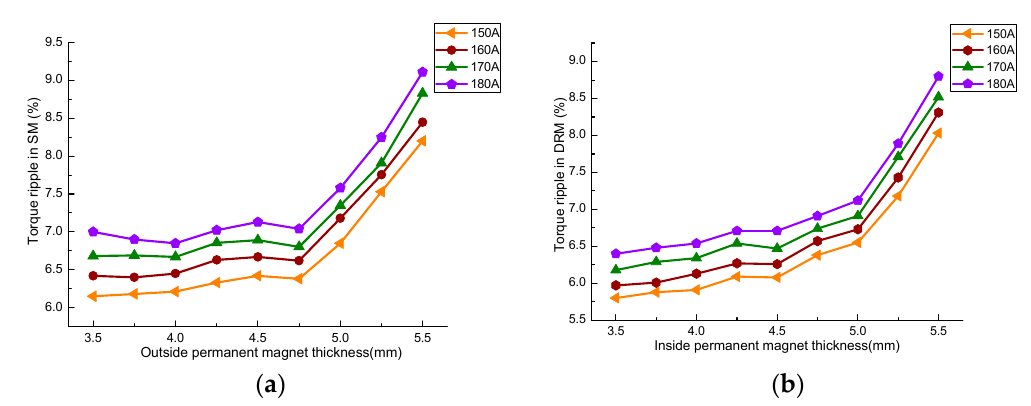
Figure 11. Relationship of torque ripple between SM, DRM, and permanent magnet thickness: ( a ) SM; ( b ) DRM.